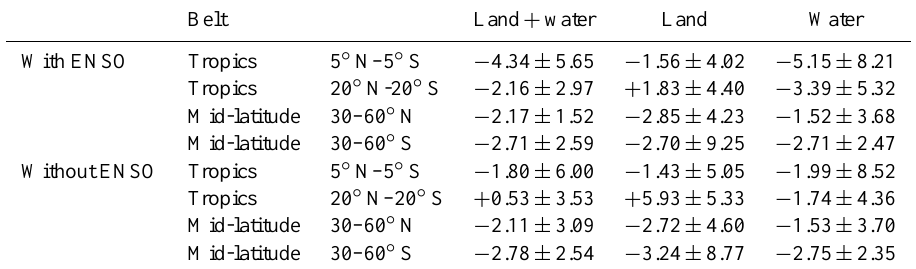
nasa.gov/gistemp/ ) dataset described in Hansen et al. [ 2010 ] . Generally, a land / sea contrast can be seen, with the highest increasing ST in the northern hemisphere over land, except for central Asia, and